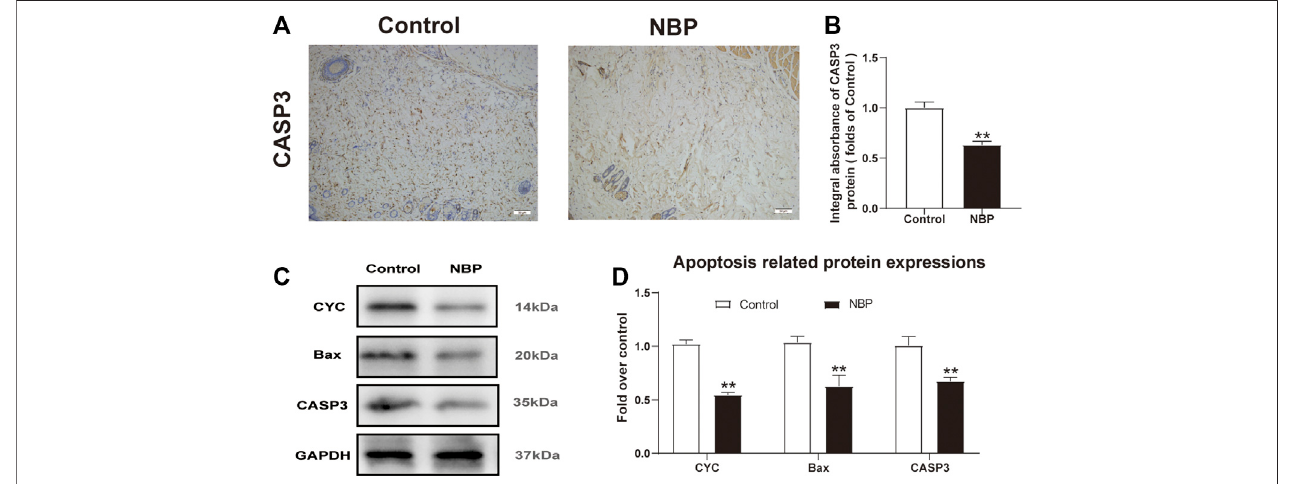
FIGURE 3 | NBP attenuates apoptosis in multiterritory perforator fl ap. (A) IHC for CASP3 in the control and NBP groups (200X); scale bar, 50 μ m. (B) CASP3 optical density for each group. (C) Western blotting of CYC, Bax, and CASP3. (D) Optical density of CYC, Bax, and CASP3 in each group. Gels were run under similar experimental conditions and cropped edited only for clarity. Values are shown as mean ± SEM, n (cid:1) 6 per group. * p < 0.05 and ** p < 0.01 vs. control group.